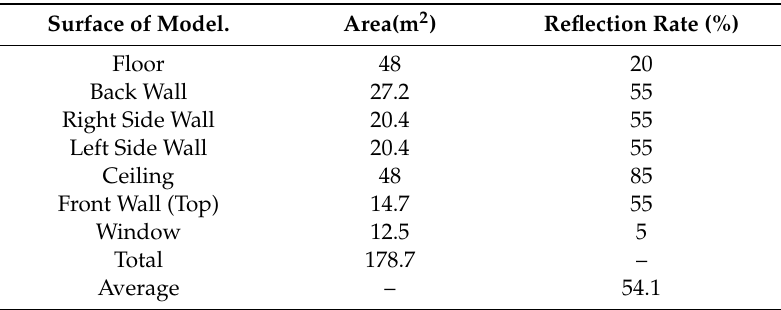
Table 1. Properties of experimental